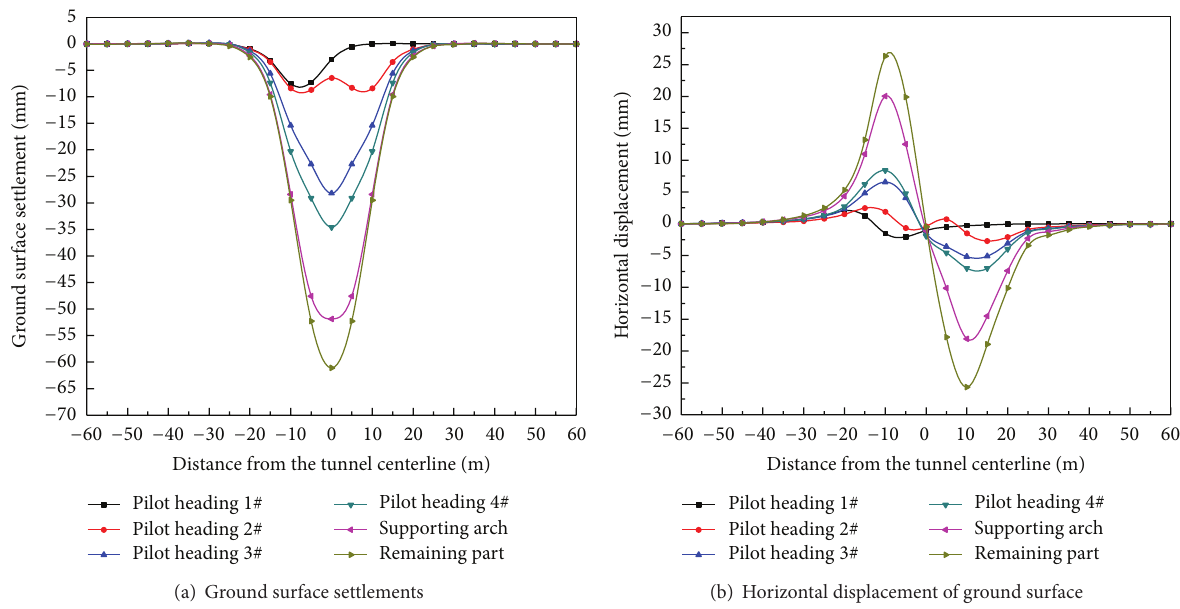
Figure 8: Ground movements induced by tunnel excavation in section 𝑧 = −30